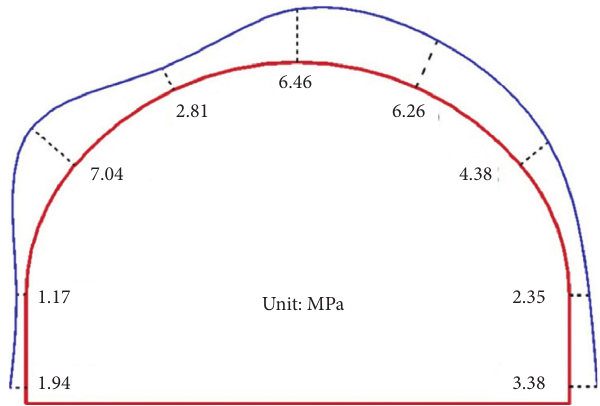
Figure 7: Stress distribution of shotcrete at section